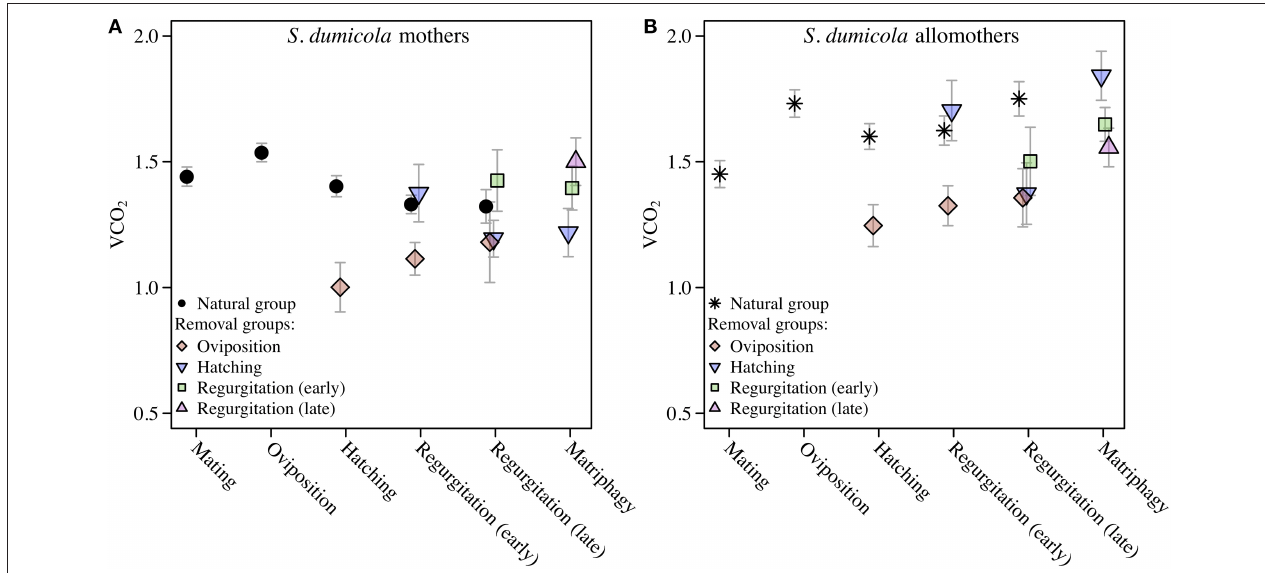
FIGURE 4 | Standard Metabolic Rate given as VCO 2 ( µ L CO2/minute/gram) in cooperative S. dumicola mothers (A) and allomothers (non-reproducing, virgin females) (B) . Natural groups followed a natural brood care cycle. SMR of mothers and allomothers was measured at mating, oviposition, hatching of offspring, early regurgitation and late regurgitation (same data as in Figure 2B ). Females in the natural group succumbed to matriphagy and were thus not measured at this stage. In the removal groups, SMR was measured after removal of the eggs (oviposition) or offspring at the same stages as given above and at expected time of matriphagy. The VCO 2 measure provided is the average of the 3 lowest measurements out of 40. Error bars show the standard error of the mean.